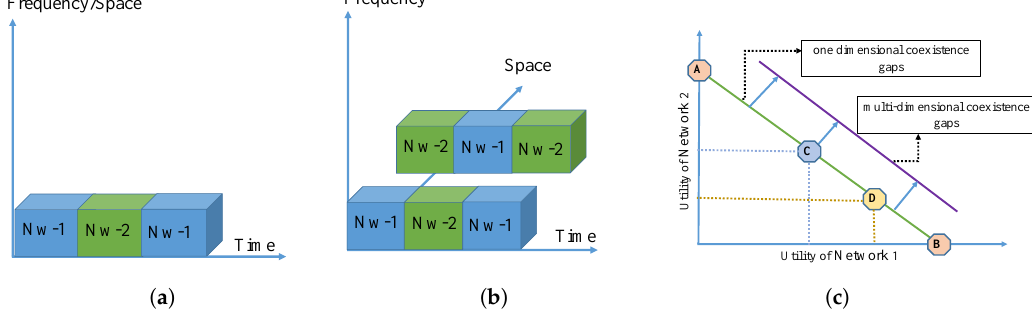
Figure 6. Multi-dimensional coexistence. ( a ) Coexistence gaps in one dimension (time domain); ( b ) Coexistence gaps in multiple dimensions (time and space domain); ( c ) The utilities of two coexisting networks.